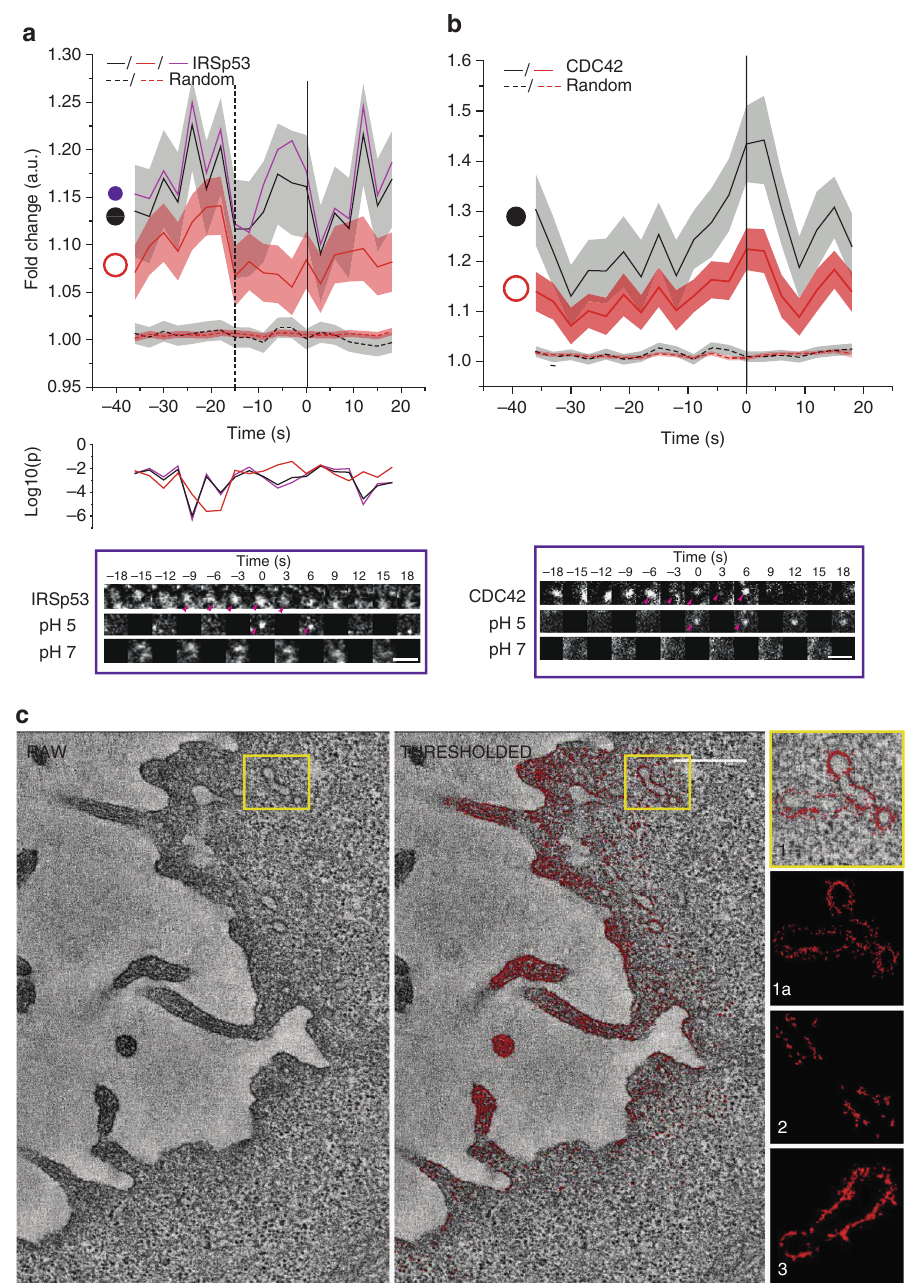
Fig. 5 IRSp53 is recruited to forming CG endosomes. a Graphs show the average normalised fl uorescence intensity vs. time traces for the recruitment of three different regions [circles, violet, r = 170 nm and black ( r = 250 nm) and annulus, orange ( r = 250 – 420 nm)] for the recruitment of IRSp53-mCherry to the forming SecGFP-GPI endocytic sites and its corresponding random intensity trace ( n , Table 1). b Graphs show the average normalised fl uorescence intensity vs. time traces for the recruitment of TagRFPt-CDC42 to the forming SecGFP-GPI endocytic sites and its corresponding random intensity trace to two different regions [circle, black, r = 250 nm; and annulus, orange ( r = 250 – 420 nm)]. Error bars, ( a – b ) represent s.e.m. ( n , Table 1). The random traces were derived from randomly assigned spots of the same radius as the endocytic regions, as detailed in S.I. Endocytic distribution at each time point was compared to the random distribution ( a ) by Mann – Whitney U test and the log 10 ( p ) is plotted below each trace [log 10 (0.05) is − 1.3 and log 10 (0.001) is − 2.5]. Representative montages are depicted below the graphs ( a – b ). Arrowheads indicate the newly formed endocytic vesicle. c Electron micrographs of AGS cells co-transfected-GFP-IRSp53 and GFP-binding protein coupled to Apex (GBP-Apex). The DAB reaction was performed and the cells were processed for electron tomography. A single section of the original tomogram (left) and density-based thresholded of the same plane (middle) reveal electron dense structures containing IRSp53 at membrane surfaces. The whole of PM of the tomographic volume was rendered and different examples of enlarged tubular regions of interest show GFP-IRSp53 recruitment patterns (right). Scale bar, 1.5 µ m ( a – b ) and 0.5 µ m ( c ),